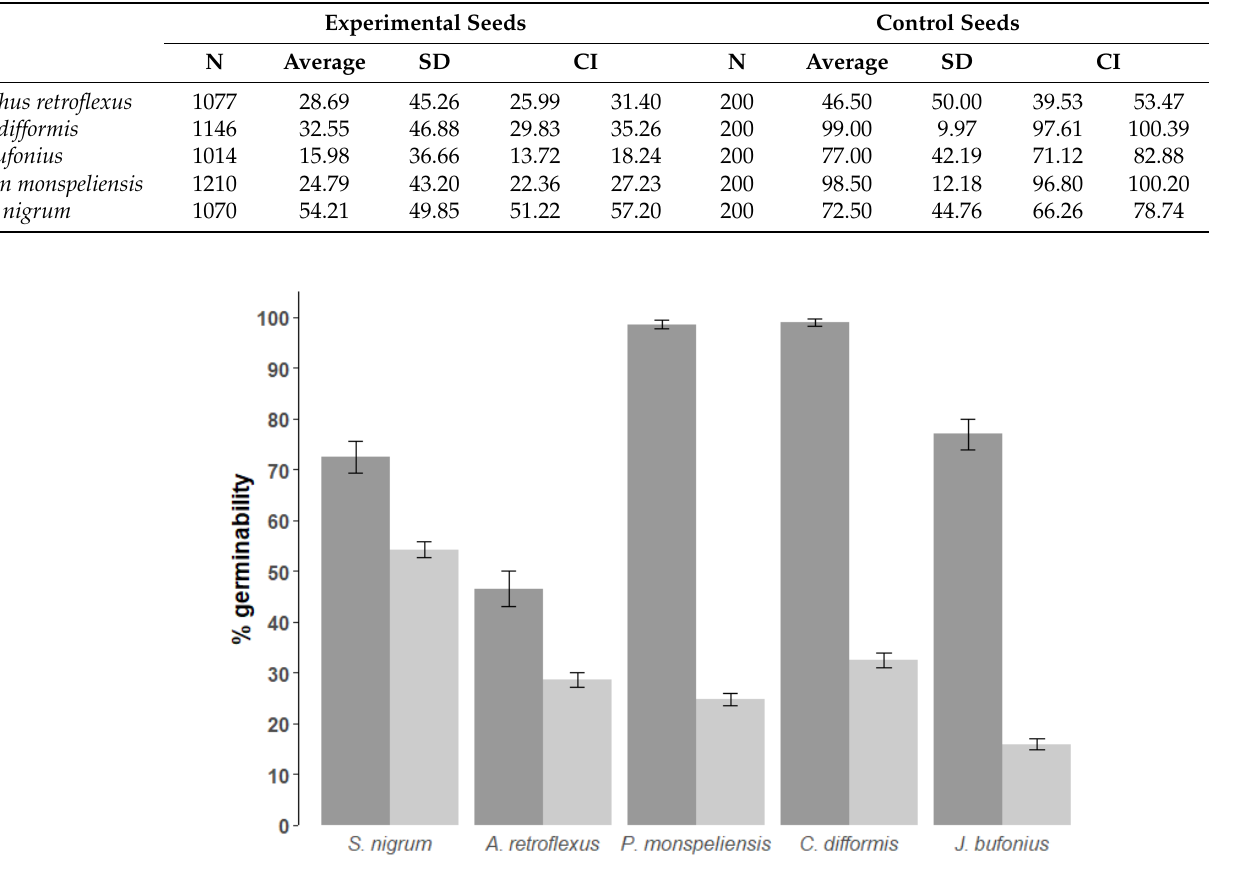
Figure 2. Differences in proportion of germinated seeds between controls (dark grey) and after gut passage (light grey), in order of decreasing seed size from left to right ( Solanum nigrum, Amaranthus retroflexus, Polypogon monspeliensis, Cyperus difformis and Juncus bufonius ). Bars represent 95% confidence intervals. All seeds were stratified before the experiment.